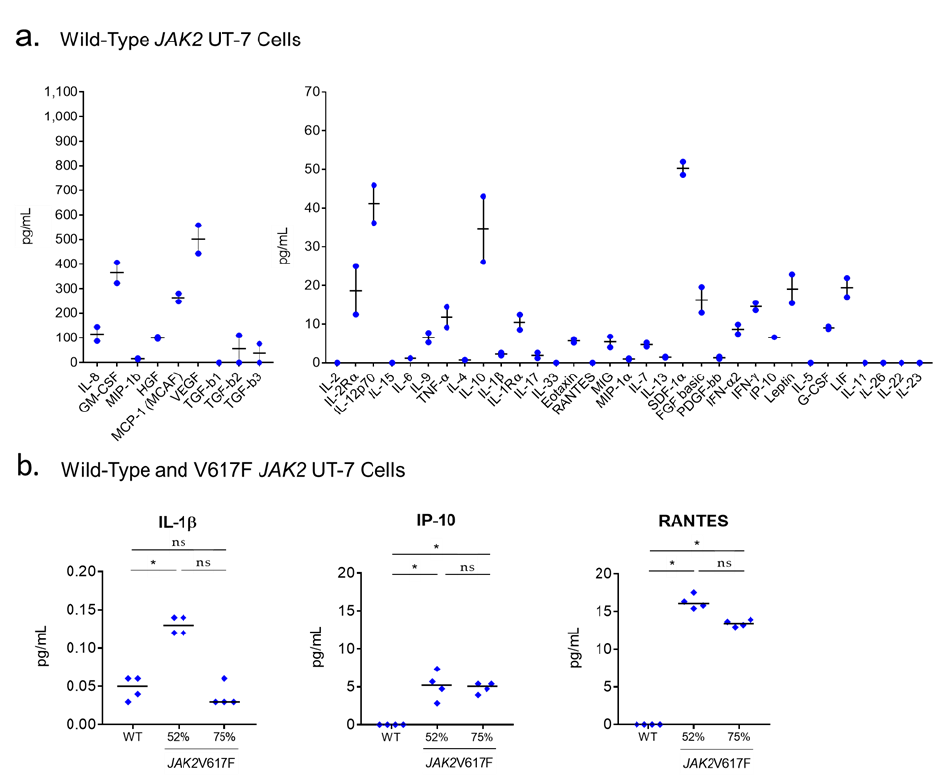
Figure 4. Cytokine production of wild-type JAK2 and JAK2 V617F UT-7 cells. ( a ) The basal level of 40 cytokines and chemokines and two soluble receptors were quantified in the supernatants of wild-type JAK2 UT-7 cells; note the di ff erence in scale for nine cytokines, produced at high levels (left panel). Results are presented as the means + SEM. ( b ) Only three molecules out of 42 measured in quadriplates in cell supernatants were found to be significantly more secreted in the supernatants of UT-7 clones expressing at least 50% JAK 2V617F, compared to wild-type JAK2 UT-7 cells; note the di ff erence in scale for IL-1 β , produced at very low levels by UT-7 cells (left panel). Median values are represented by black bars. (*) p < 0.05, Mann–Whitney t -test. In these experiments, UT-7 cells were grown in the presence of